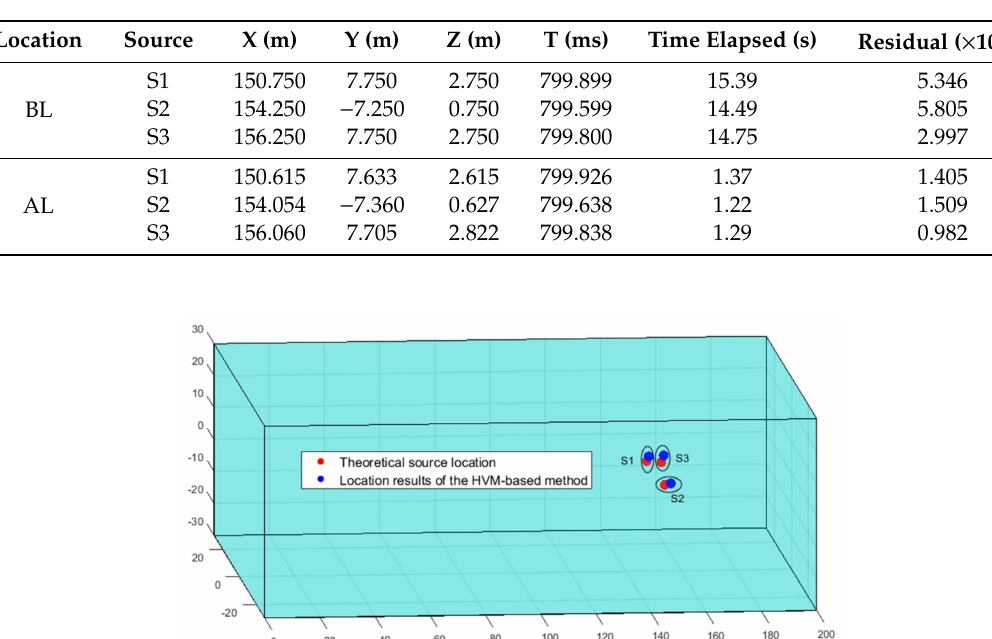
Table 3. Block localization (BL) results and accurate location (AL) results.